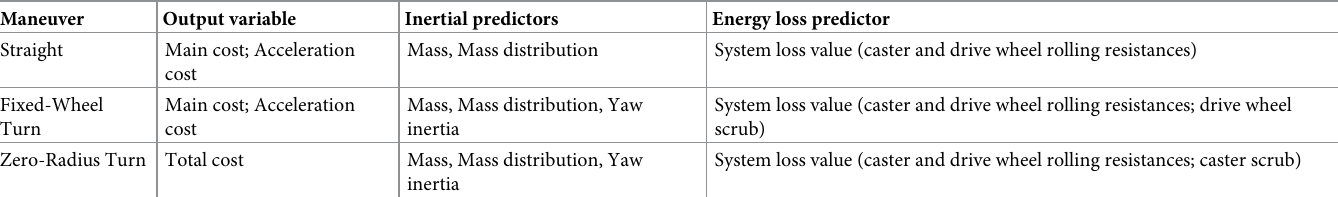
Table 2. Outcomes and predictors. Descriptions of the output variables and the predictor variables for each